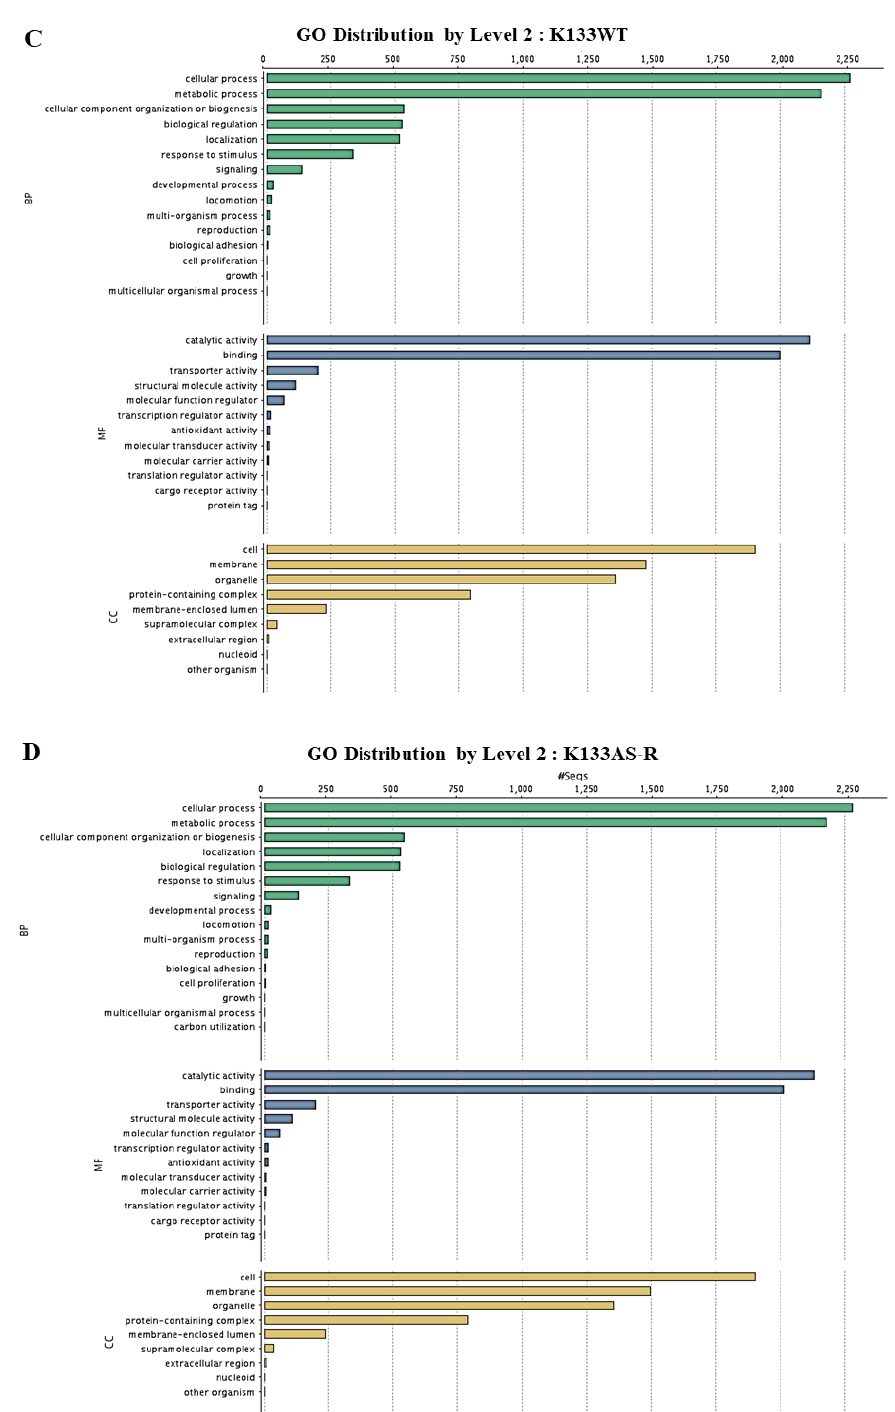
Figure 4. Characterization of K133WT and K133AS-R unigenes based on an NCBI non redundant (Nr) protein database search. ( A ) Species distribution of the top Blast hits for the K133WT assembled unigenes and ( B ) Species distribution of the top Blast hits for the K133AS-R assembled unigenes with a cuto ff E-value of 10 − 05 . Gene Ontology (GO) annotation for all the assembled unigenes in K133WT ( C ) and K133AS-R ( D ) GO-terms were assigned to functionally annotate the genes based on BLAST search results using the Blast2GO program (Biobam BioInformatics, Valencia, Spain). The results were classified based in three functional categories, Green bar represents biological function (BF); Blue: molecular function (MF); and Yellow: cellular component